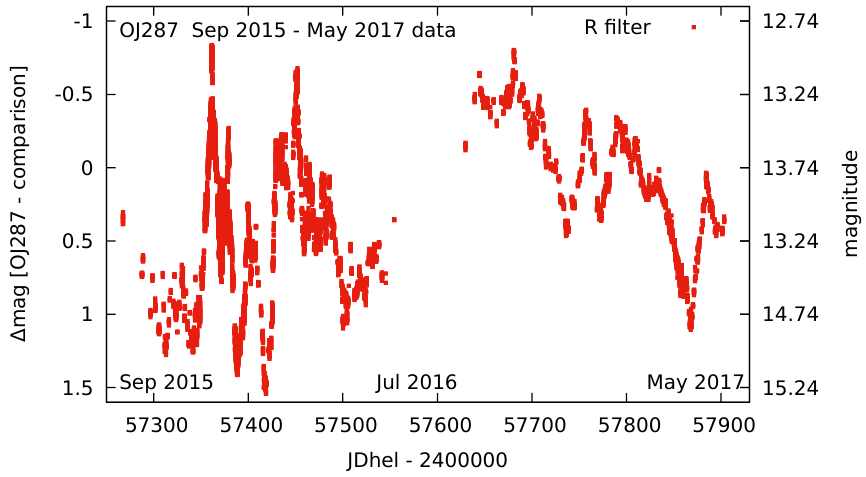
Figure 2. Light curve of OJ 287 observed during the 2015/16 and 2016/17 seasons. The gap in summer 2016 is due to OJ 287’s conjunction with the